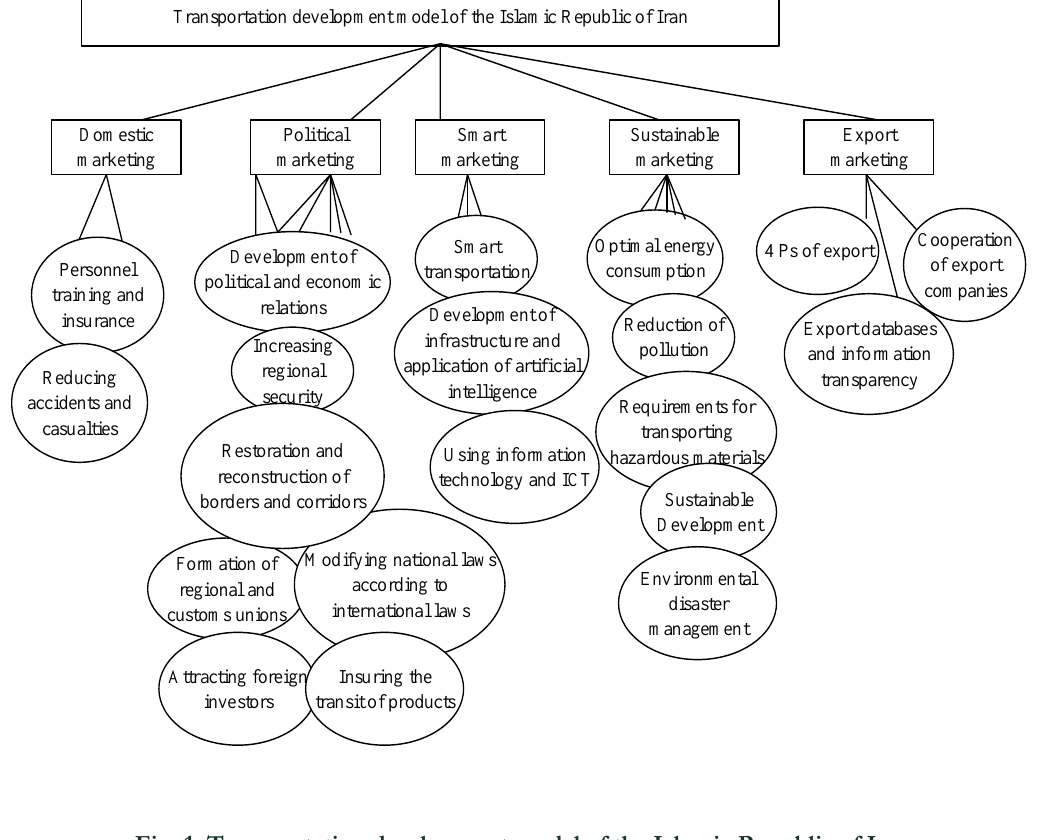
Fig. 1. Transportation development model of the Islamic Republic of Iran.